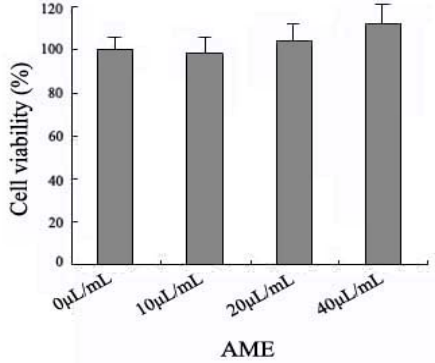
Figure 1. Viability analysis of AME on Ana-1 macrophages. Cells (5 × 10 4 ) were treated